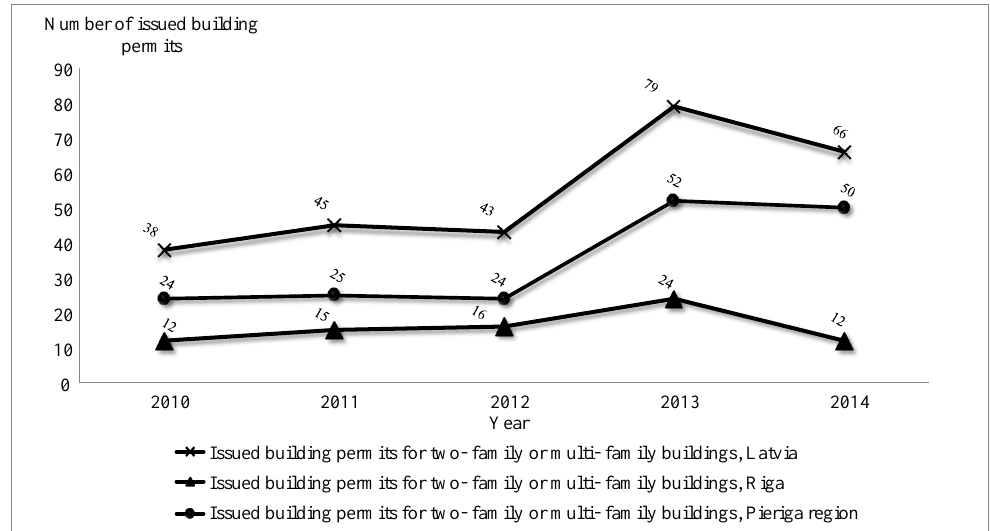
Fig. 5. The number of building permits issued for newly erected two-family or multi-family buildings in the period of 2010–2014 in Latvia as a whole as well as in Riga and Pieriga statistical region (CSP, 2015 e ) [Figure made by the